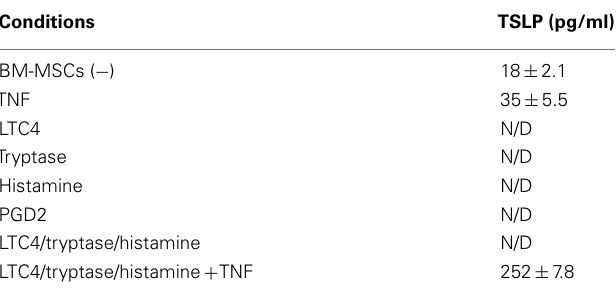
Table 1 | Mast cell mediators’ effect on the release ofTSLP by BM-MSCs.